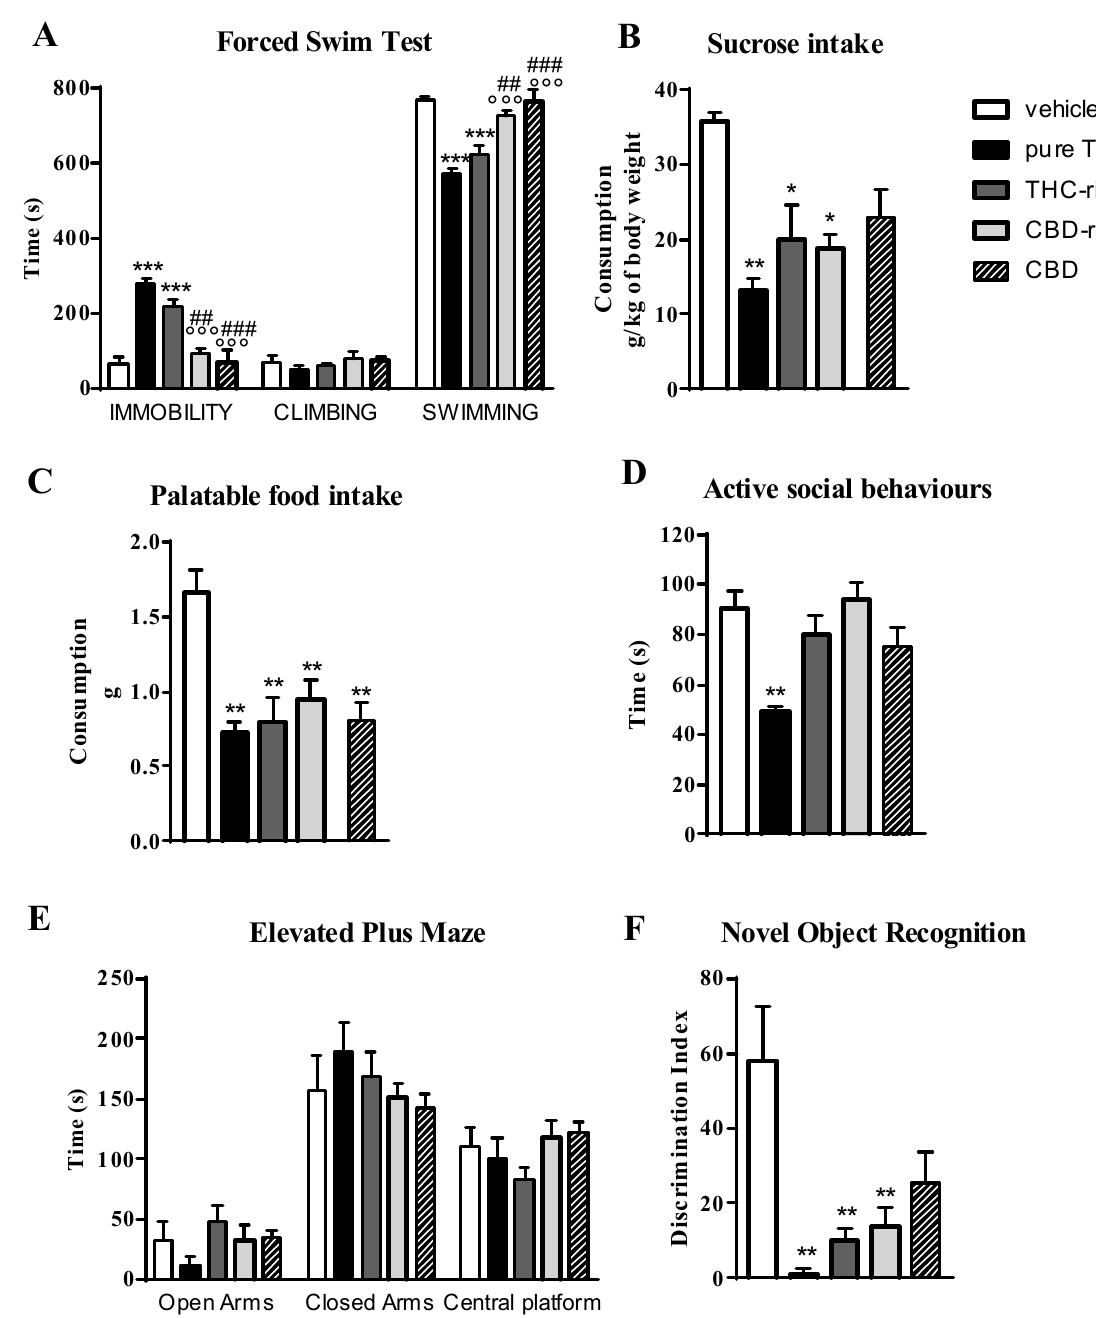
Figure 4. Behavioral responses of adult female rats following adolescent administration of pure THC, THC/CBD combinations or CBD in the forced swim test (panel A ), sucrose intake (panel B ), palatable food intake (panel C ), social interaction test (panel D ), elevated plus maze (panel E ), novel object recognition test (panel F ). Data are expressed as mean ± SEM of 4 animals per group. * p < 0.05, ** p < 0.01, *** p < 0.001 vs. vehicle; ◦◦◦ p < 0.001 vs. pure THC; ### p < 0.001, ## p < 0.01